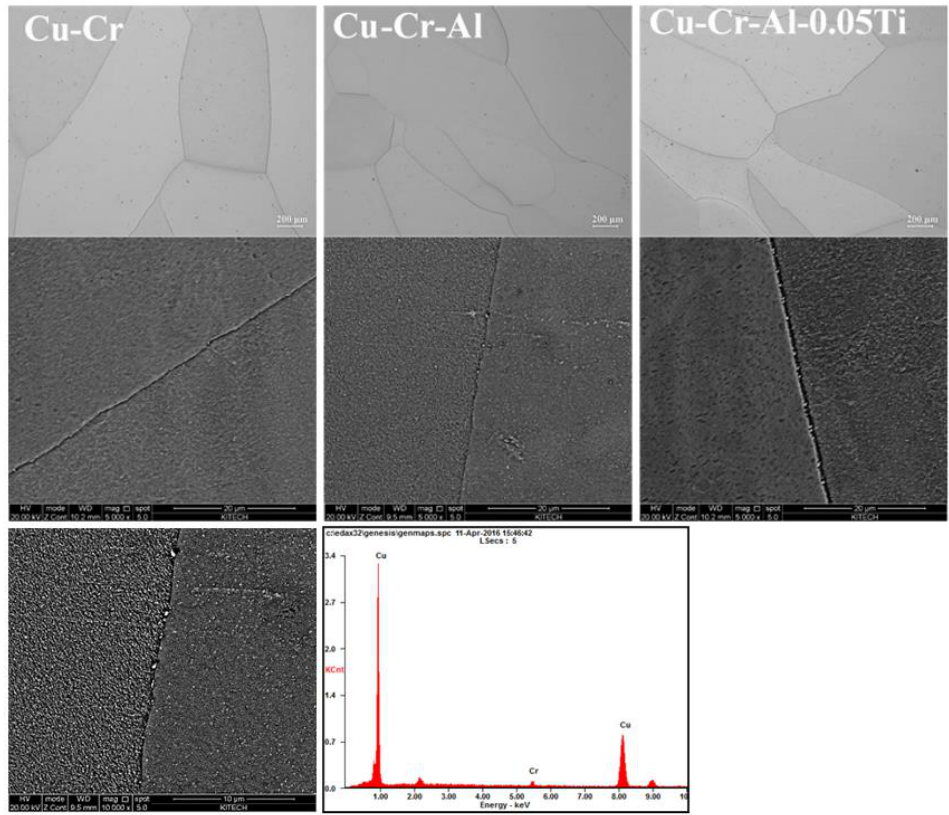
Figure 2. Microstructures of Cu-Cr alloys as cast by SEM.